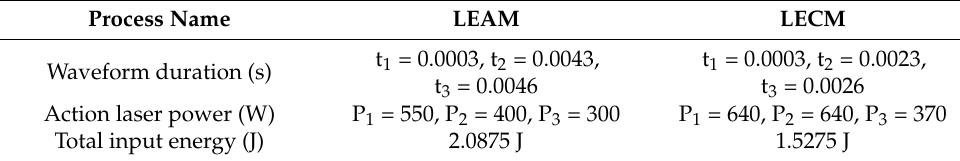
Table 1. Chemical composition of 304 stainless steel sheet (mass fraction, %).